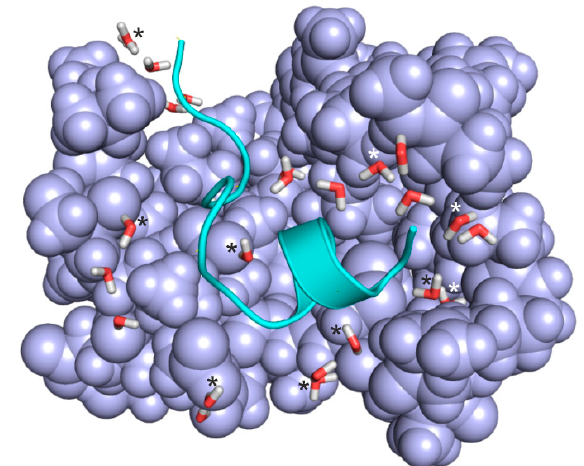
Figure 4. Extracted complex interface of System 2bba after relaxation at semi-empirical level using PM7 parameterization and Mozyme. Target fragments and ligand are shown in light blue space filling and green cartoon representations, respectively. Water molecules (sticks) in Shell 1 are marked with asterisks. Non-marked waters belong to Shell 2.